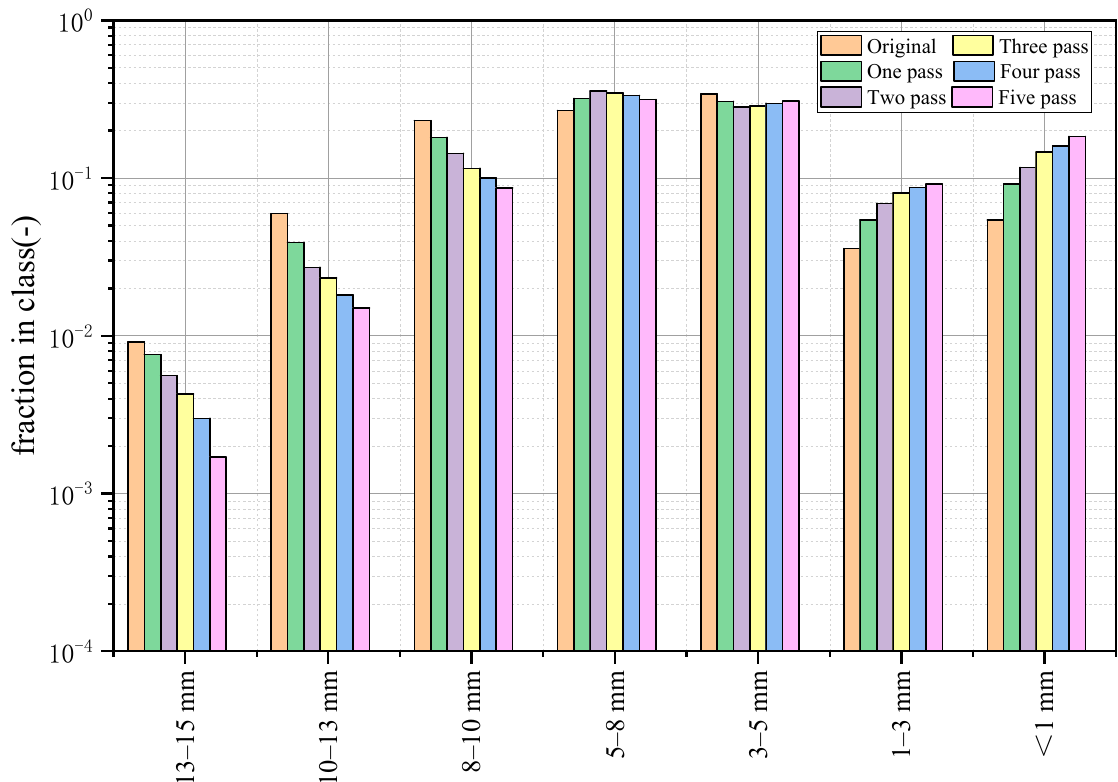
Figure 8. Vibrating screening machine.